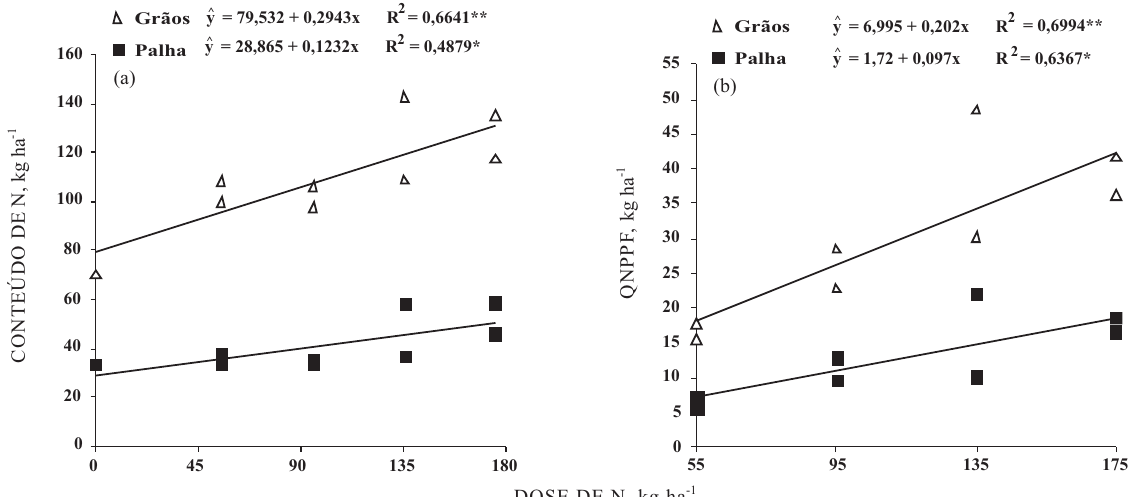
Figura 2. Quantidade de N acumulada no milho (a) e quantidade de N no milho proveniente do fertilizante (b), em função de doses de nitrogênio. (* e **: significativo a 5 e 1 % pelo teste F, respectivamente).